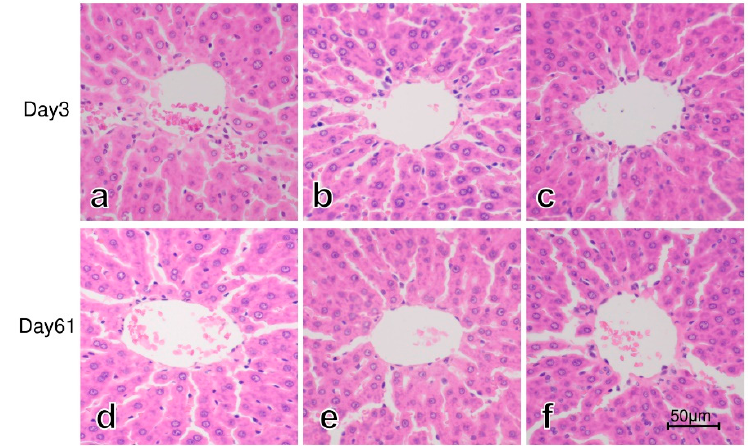
Figure 1. Liver of rats on day 3 ( a – c ) and day 61 ( d – f ) after the exposure to 56 MnO 2 particles or 60 Co- γ rays. No significant histological changes were noted in Mn56x3 ( a , d ), Co60 ( b , e ), and the control ( d , f ) groups. HE staining, original magnification 400×. A bar indicates 50 µm.